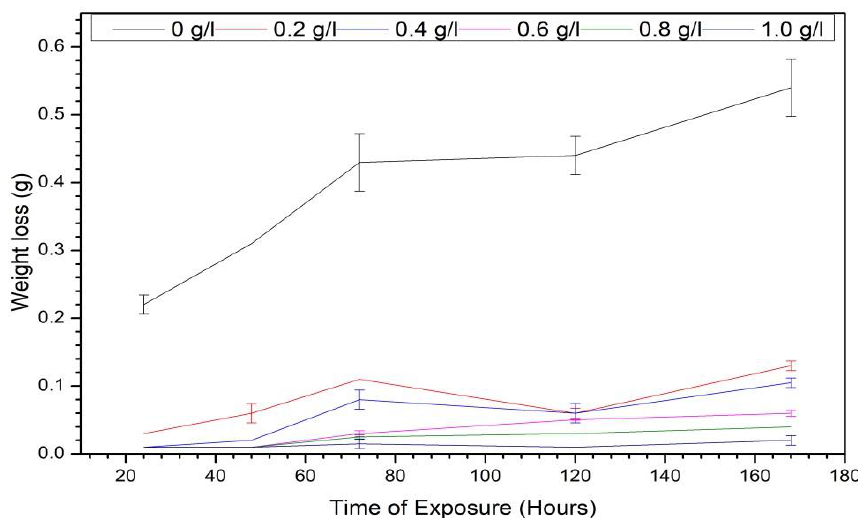
Figure 7: Variation of mass loss with time for the corrosion of low carbon steel in 1M HCl with and without inhibitor.